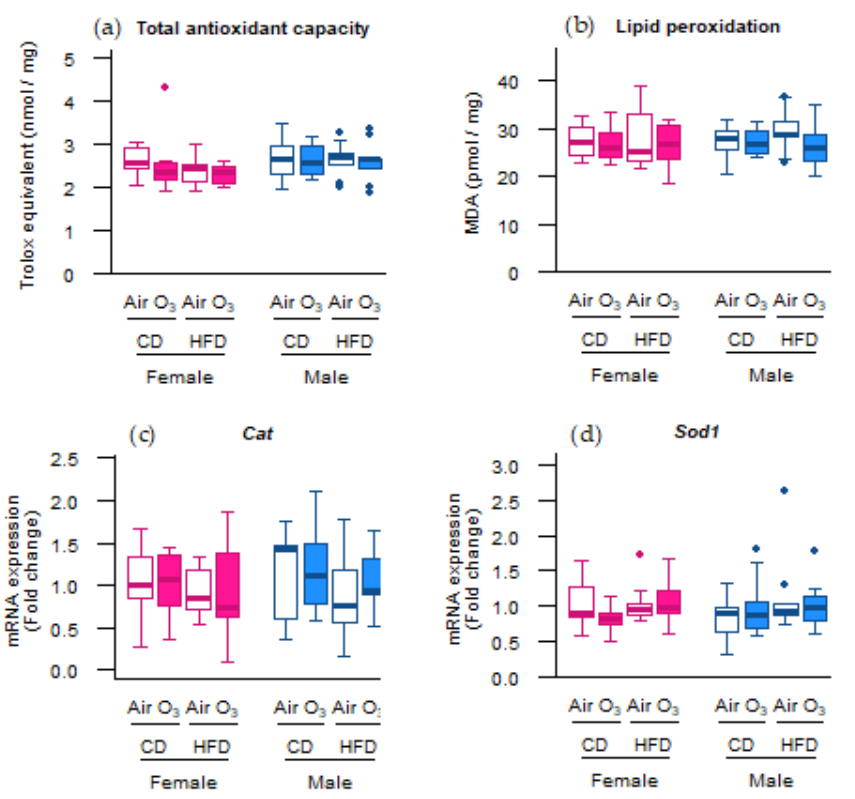
Figure 2. Acute ozone exposure and perinatal high-fat diet (HFD) did not alter the pulmonary ( a ) total antioxidant capacity, ( b ) lipid peroxidation, or expression of cytoplasmic antioxidant genes ( c ) Cat and ( d ) Sod1 . All of the markers were assessed within two hours after exposure to filtered air or ozone in the lungs of female and male offspring from dams fed a perinatal control diet (CD) or HFD. Data are presented as boxplots. Statistical analysis by two-way ANOVA with a Holm–Sidak post-hoc test. n = 10 per group ( a , b ) or n = 9–10 group ( c , d ). O 3